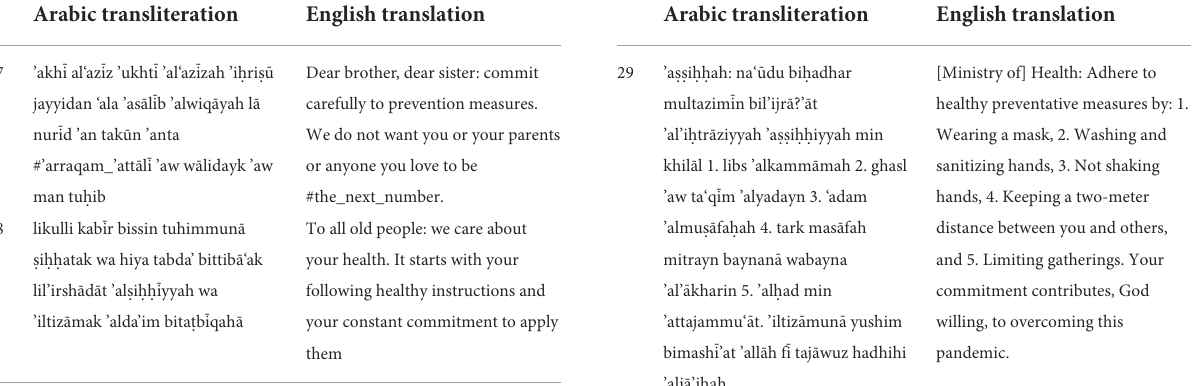
TABLE 10 Examples of the use of the liking–commitment–social proof pattern.